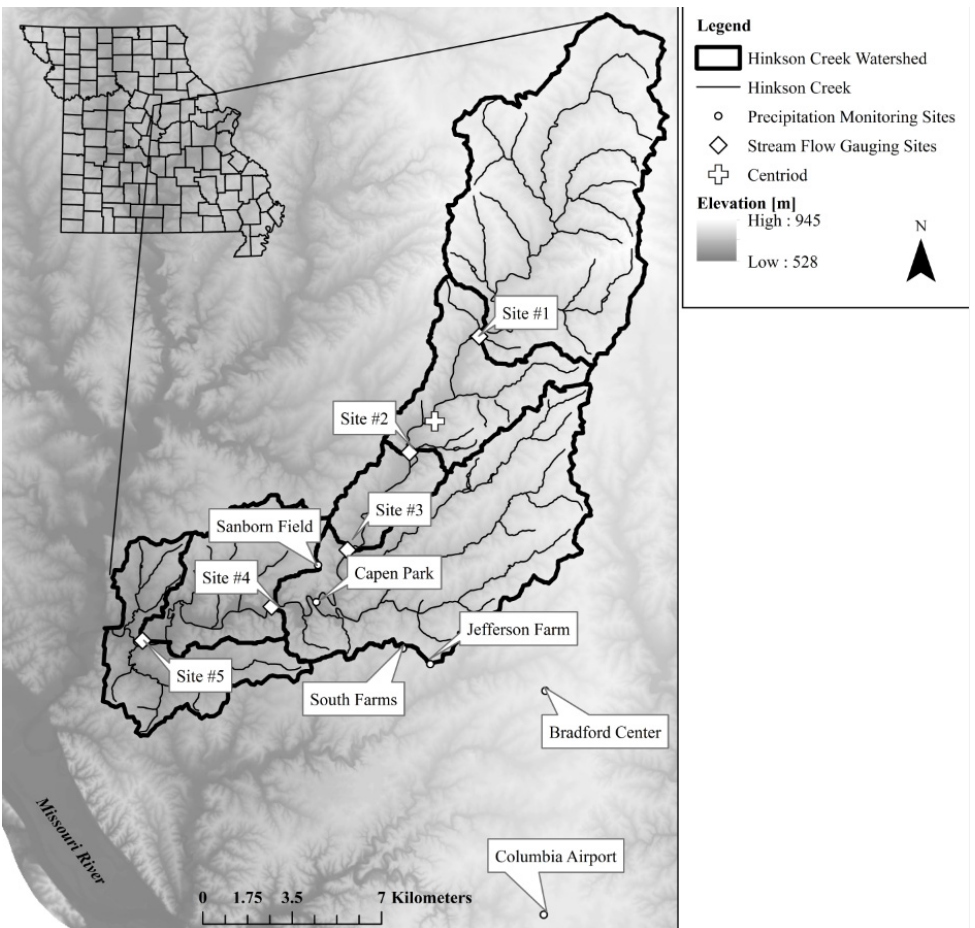
Figure 1. Location of precipitation monitoring sites, stream flow gauging sites, and respective sub-basins of the Hinkson Creek Watershed, Missouri, USA. A cross shows the centroid of the Hinkson Creek Watershed located upstream of the stream flow gauging Site #2. Precipitation was estimated at precipitation monitoring sites and stream flow gauging sites.